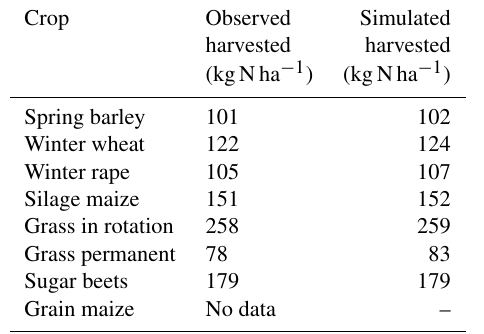
Table 3. Observed and simulated harvested N in kilograms of nitro- gen per hectare (kgNha − 1 ) for the crop types on Funen during the calibration period (2004–2007). Grain-type crops are identified as harvested N in the grain, while the remaining crops are calculated as total harvested dry